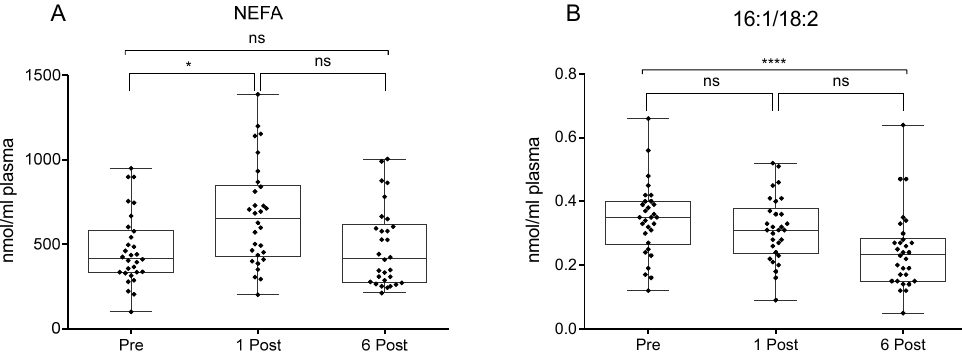
Figure 4. Ratios of 22:6-n3/20:5-n3 ( A ) [31,33], and 20:4-n6/18:2-n6 ( B ) [36] in subjects at baseline (Pre), one month (1 Post) and six months (6 Post) after bariatric surgery. Values, expressed as mol % of total fatty acid (FA), are presented as boxes (mean value) and whiskers (higher and lower values) ( n = 33). *** p < 0.001; **** p < 0.0001.